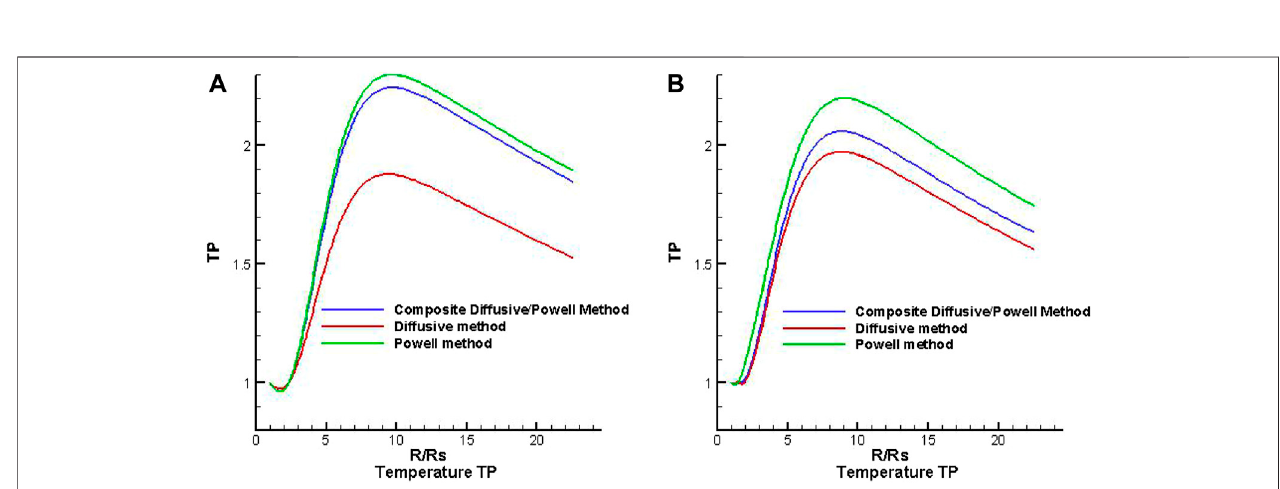
FIGURE4| Thedistributionofdensity RO (/cm 3 )alongheliocentricdistancewithdifferentlatitudesof θ (cid:2)− 80 ° (A) and θ (cid:2)− 10 ° (B) atthesamelongitude Φ (cid:2) 0 ° from three divergence methods.